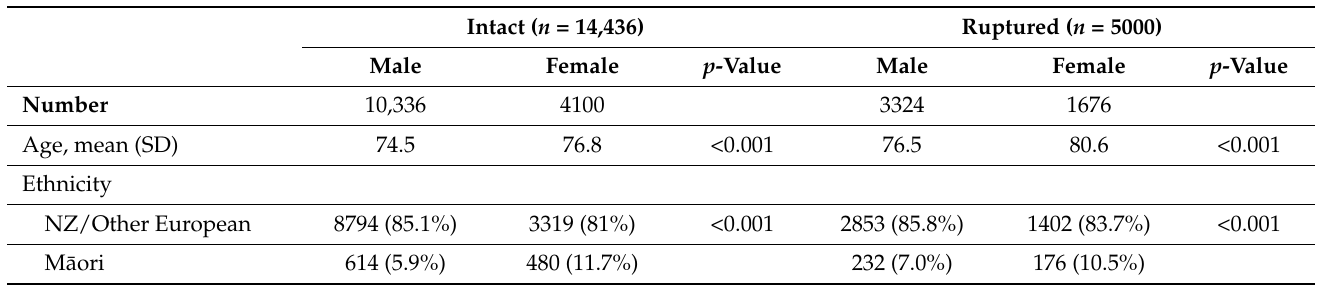
Table 1. Patient characteristics for intact and ruptured AAA index presentations stratified by sex. Intact AAA data from 2001 to 2021 and ruptured AAA data from 2001 to